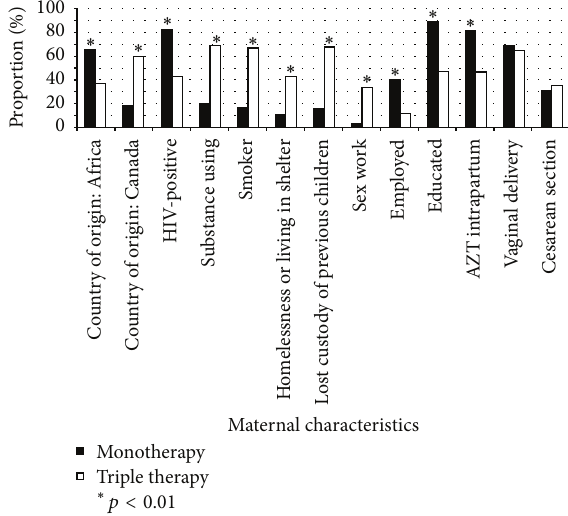
Figure 1: Proportion with selected maternal characteristics in newborn-monotherapy versus newborn-triple therapy